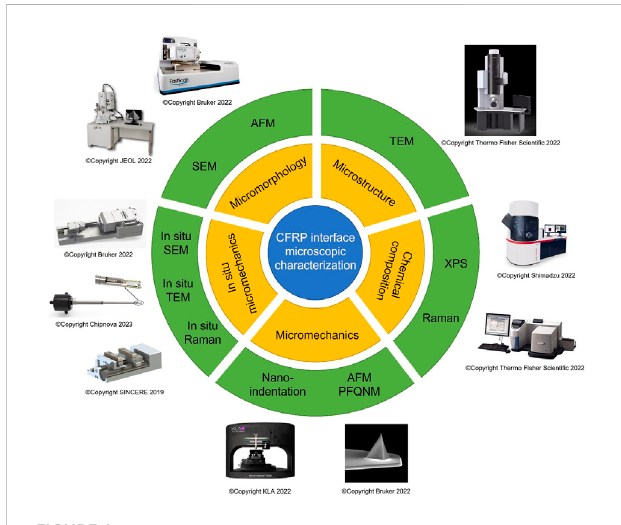
FIGURE 1 Schematic diagram of interface microscopic characterization methods of CFRPs.